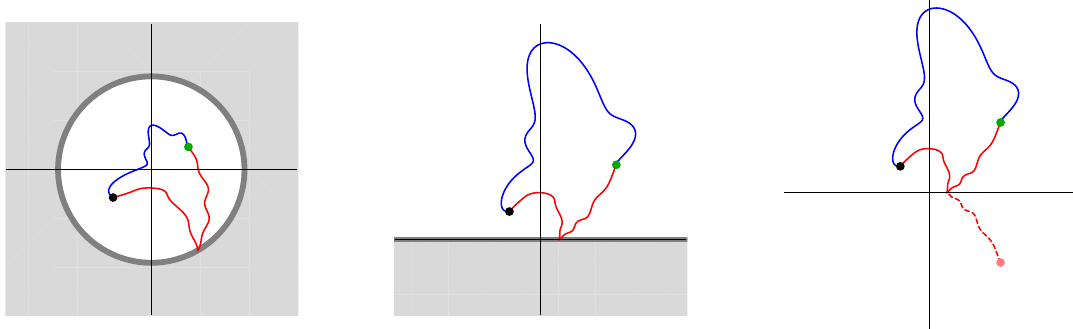
Figure 1 . Worldlines in D = 2. The (cid:12)rst (cid:12)gure from the left shows two worldlines inside the disc B 2 from the initial point (cid:15) to the (cid:12)nal point (cid:15) : the blue trajectory lies entirely within the bulk; the red one hits the boundary once. The second picture displays the same elements after a conformal transformation. The last picture represents ~ B 2 : the boundary turns into an interface. A typical curve that hits the boundary (from (cid:15) to (cid:15) ) has a corresponding curve (from (cid:15) to (cid:15) ) where the last segment from the boundary to the end-point is switched to its re(cid:13)ection with respect to the interface. The contribution of the original curve is called \direct"; the second,